Question: Express in one sentence what the figure is showing.
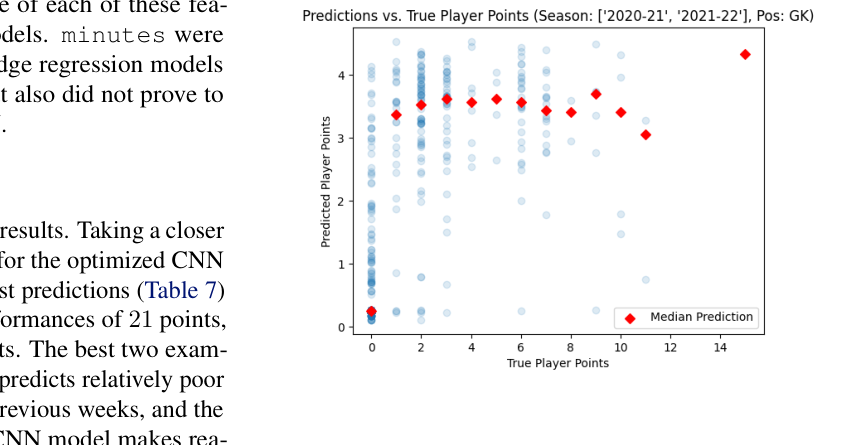
Answer: Defender Predictions vs. True Performance (Holdout Data)